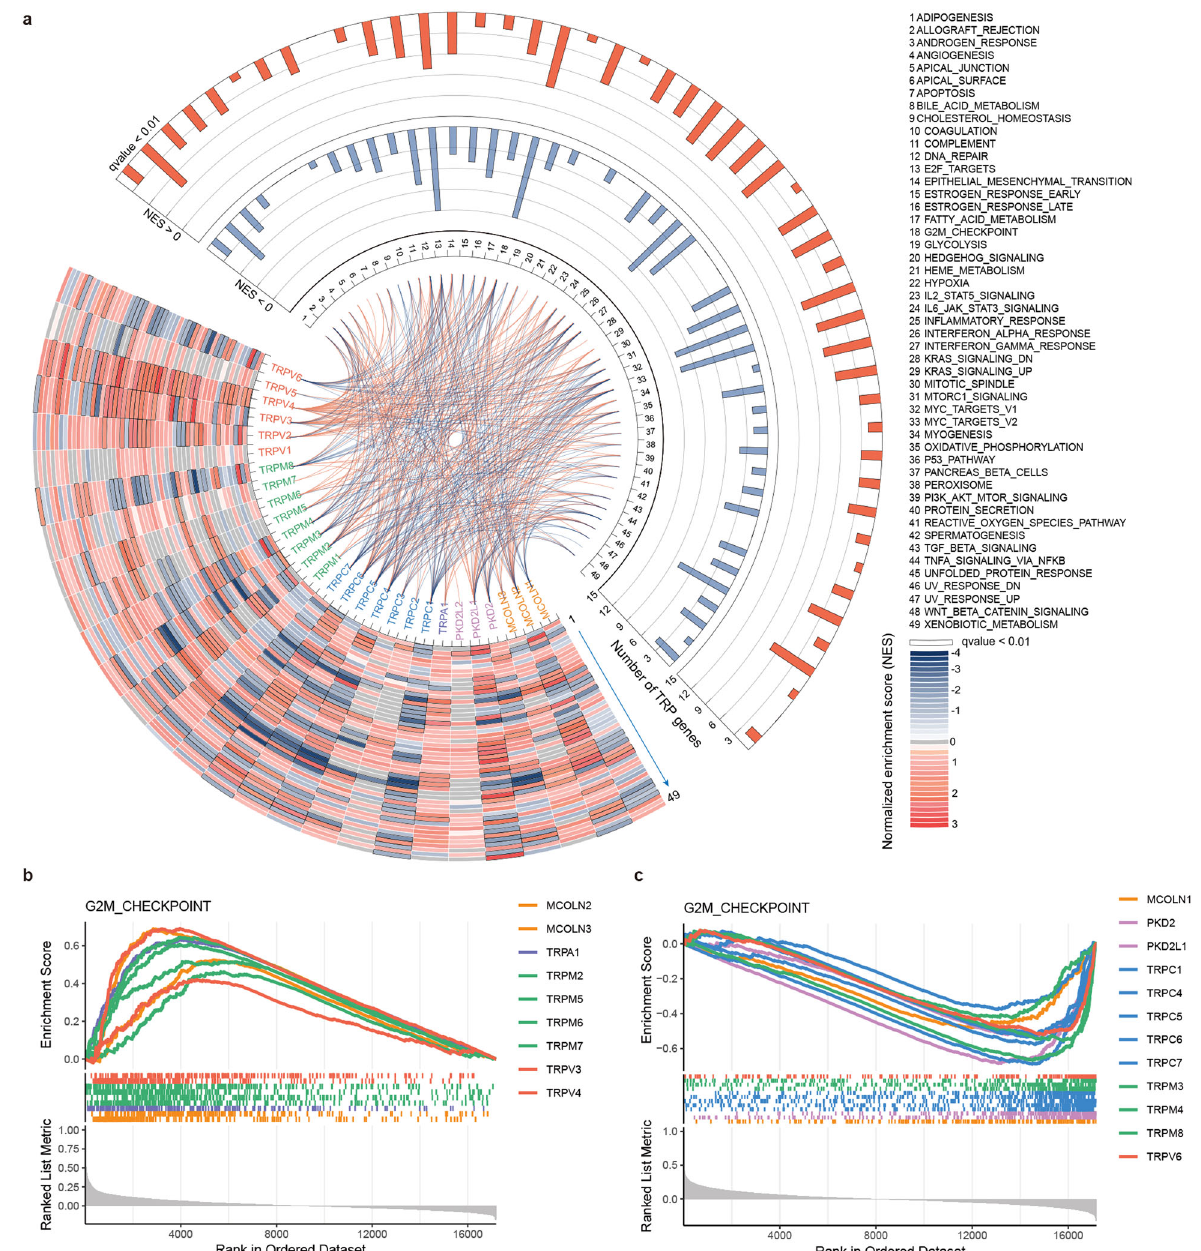
Fig. 6 Functional pathways of TRP genes across cancer types. a TRP gene expression correlated with cancer pathway activities. The heat map showing the normalized enrichment scores of GSEA analysis. Pathways were indicated by numbers 1 to 49. The bar plots showing the number of TRP genes that correlated with each cancer pathway. Blue for negatively correlated and red for positively correlated pairs. The inner lines showing the signi fi cant TRP gene-pathway pairs. b , c The enrichment score (ES) distribution for the genes positively or negatively co- expressed with TRP genes in G2M checkpoint pathway. Each line is for one TRP gene and lines are colored by TRP